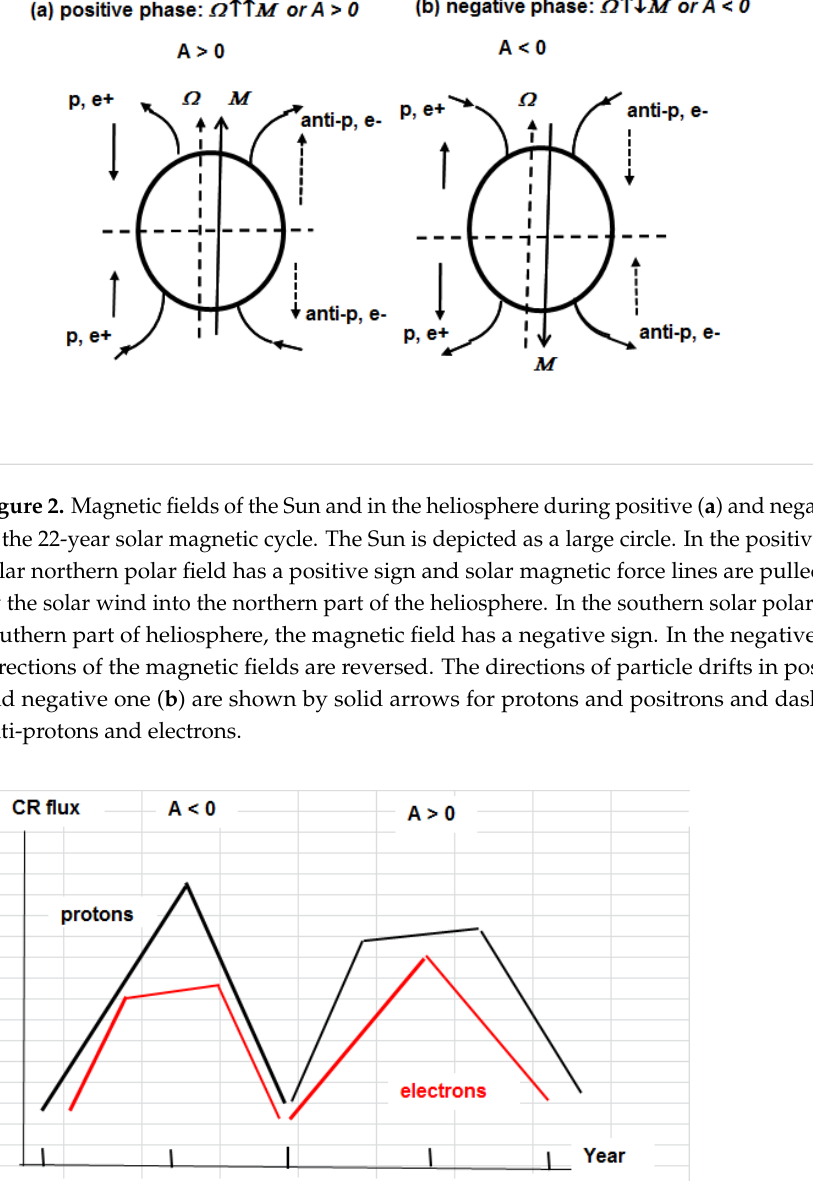
Figure 3. Schematic representation of the time dependence of cosmic ray fluxes with positive electric charges (protons or positrons, black curve) and negative electric charges (electrons or anti-protons, red curve) in the positive (A > 0) and negative (A < 0) phases of the 22-year solar magnetic cycle. The periods of solar activity maxima and minima in the 11-year solar activity cycles are depicted as max SA and min SA. The time interval between consecutive max SA (min SA) is ~11 years.